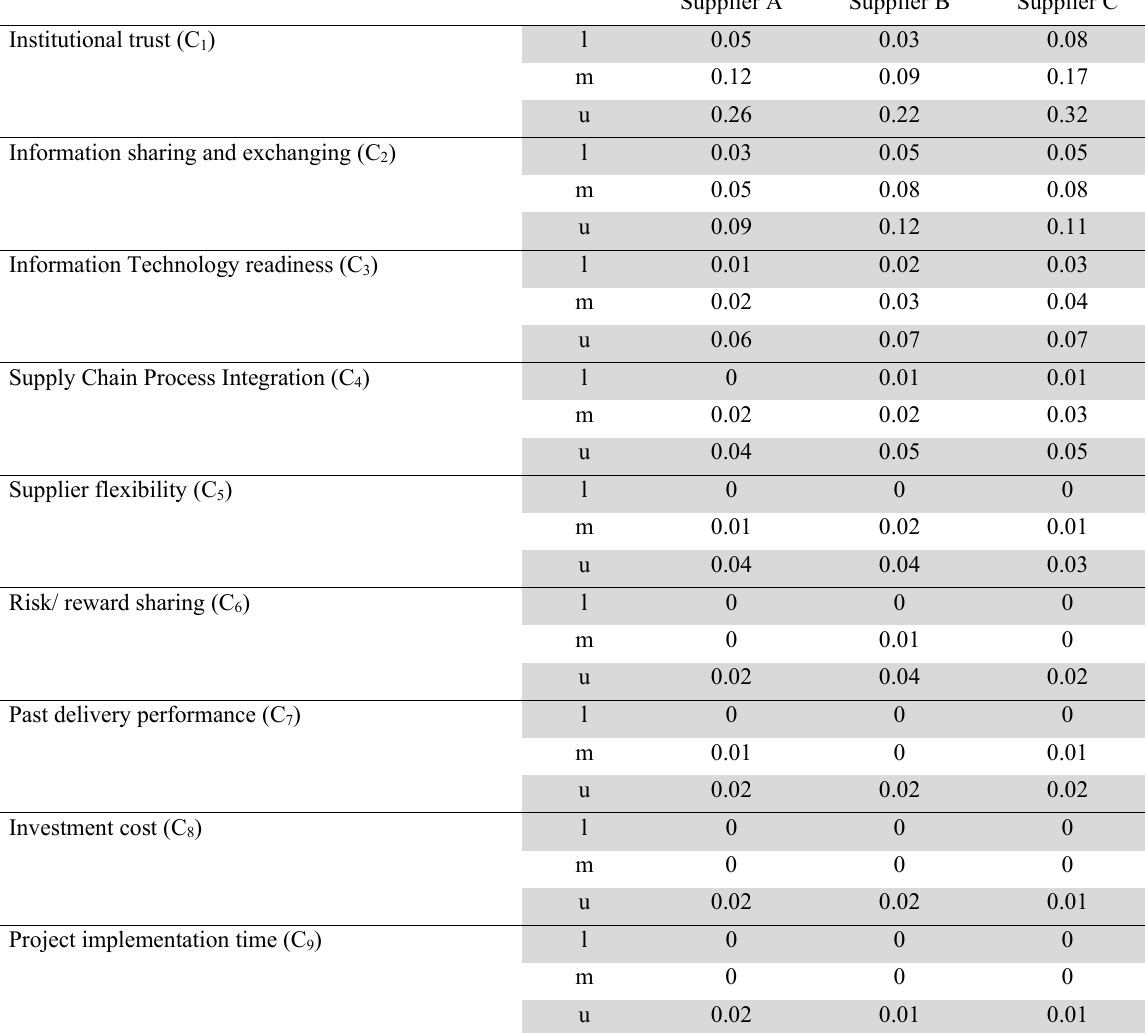
The weighted normalized fuzzy decision making matrix